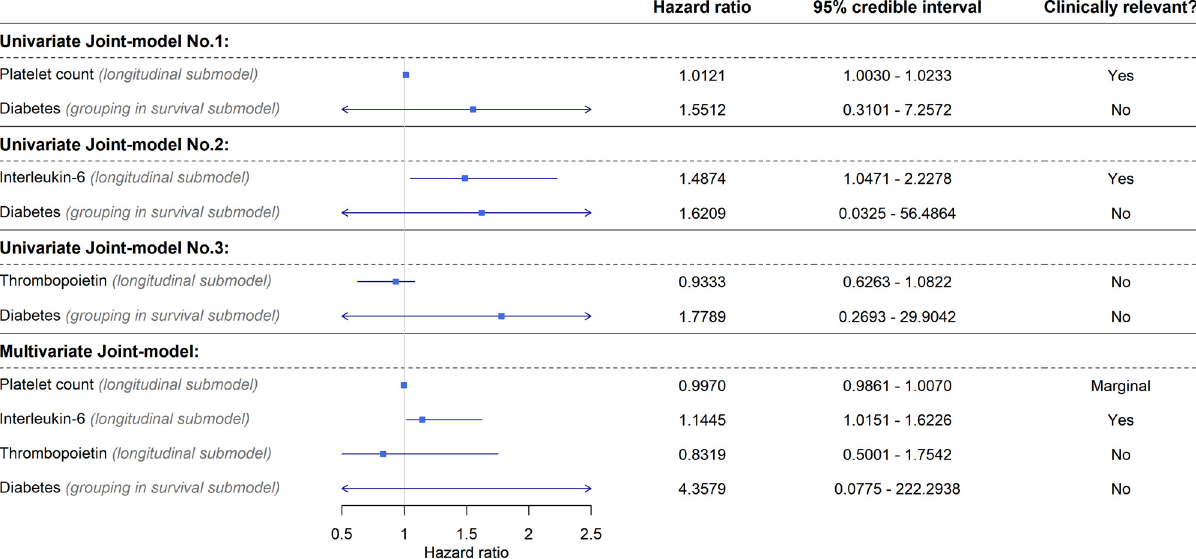
Figure 5: Results of the Bayesian joint survival models. Platelet count and/or plasma interleukin - 6 level increasing over time is a poor prognostic factor, whereas diabetes and plasma thrombopoietin changes did not a ff ect patient survival ( Note: credible interval is the Bayesian equivalent of the frequentists ’ CI. )